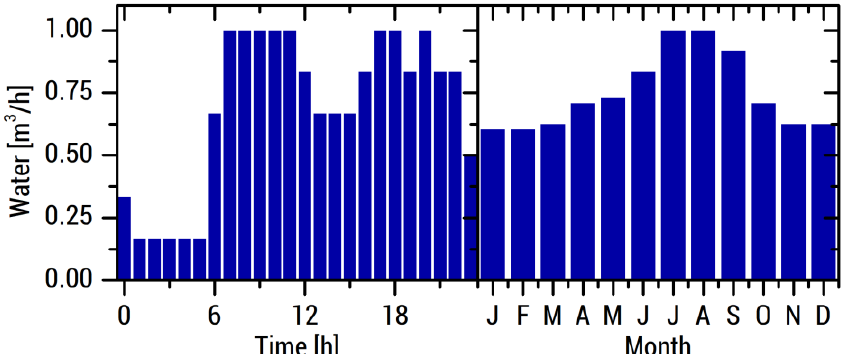
Figure 7. Normalized water demand profile. This is scaled up to match the annual demand. The left